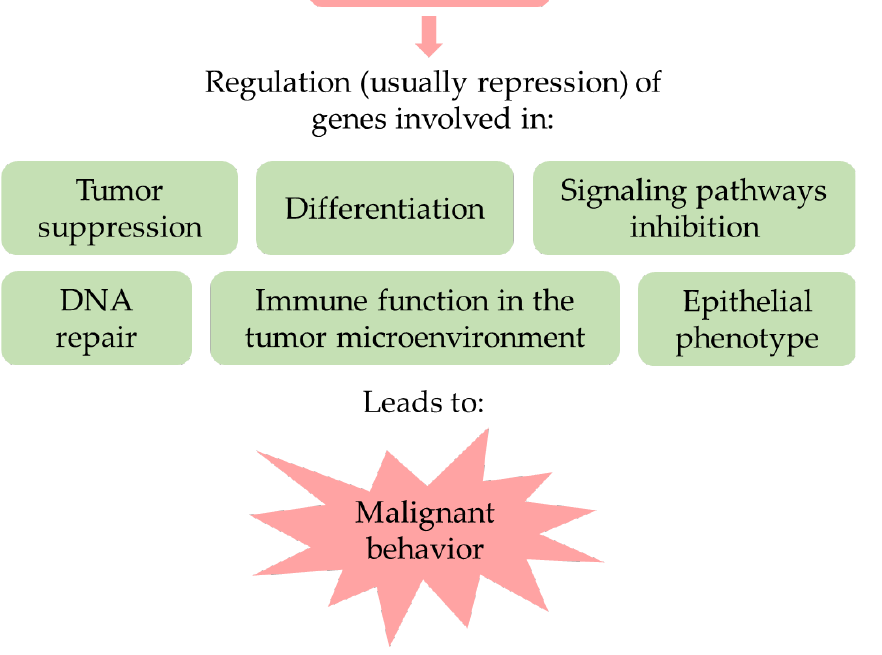
Figure 1. Generalized summary of EZH2 activities in cancer. Some of these roles offer an opportunity for therapeutic intervention, such as the modulation of the immune function. The roles of EZH2 in the epithelial – mesenchymal transition and DNA repair are complex and opposing and the cell context dependent.